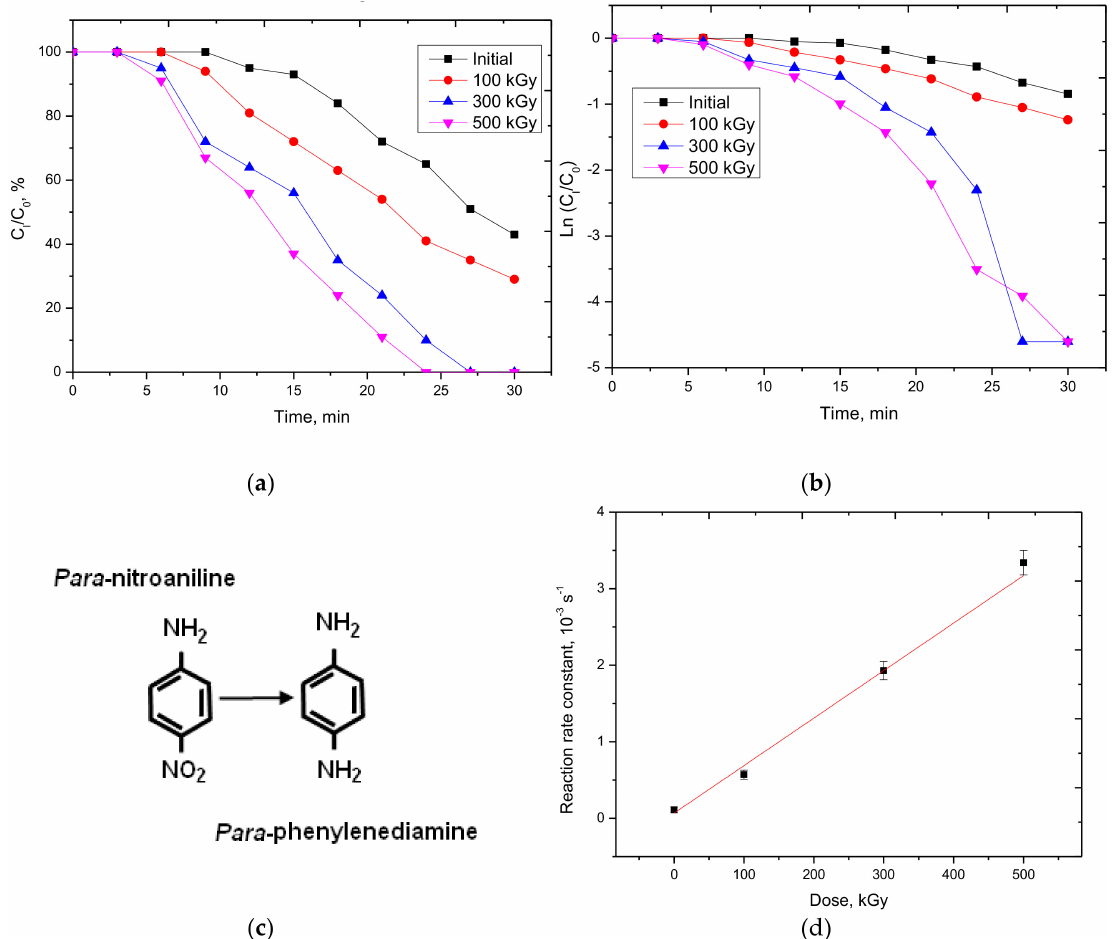
Figure 10. Graphs of the dependence of the changes in C I / C 0 ( a ) and LnC I / C 0 ( b ) reflecting the catalytic activity of the studied nanostructures. ( c ) PNA-PPD reaction scheme. ( d ) The graph of the change in the rate of reaction constant (dots indicate experimental data; red lines indicate approximations of the